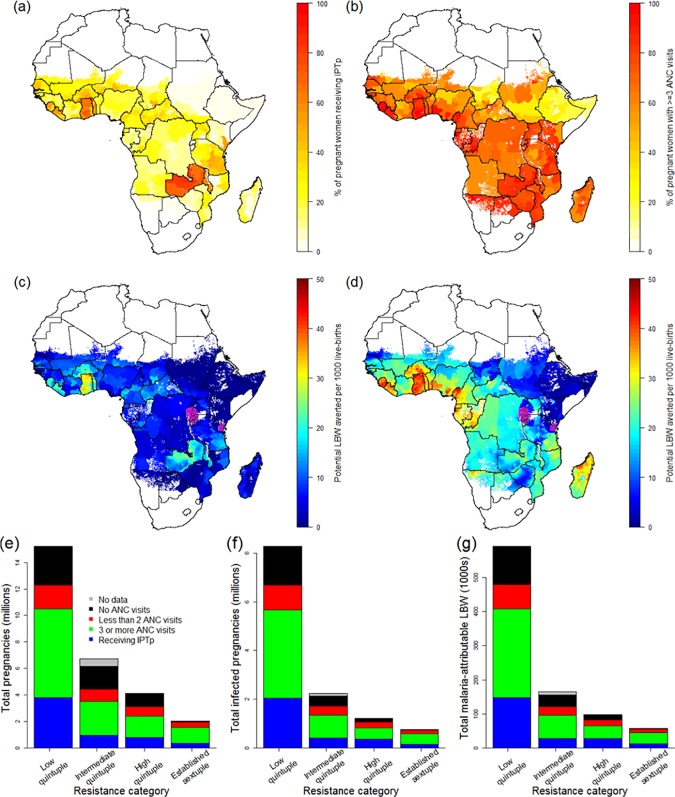
The current coverage of IPTp-SP and potential impact of scale-up.(A) Current coverage of IPTp (at least two doses of SP received at some stage during pregnancy) by first administrative unit according to the most recent population-based survey. (B) Current coverage of women visiting an ANC clinic at least three times during pregnancy. (C) Estimate of the current impact of IPTp-SP given current coverage, SP resistance, and transmission intensity (purple areas show settings where the sextuple mutation has become established, where we do not make an estimate of efficacy). (D) Estimate of the impact of IPTp-SP if given to all women visiting an ANC clinic at least three times, with purple areas as in (C). (E) Estimates of the total number of pregnancies receiving IPTp, and the ANC status of those who do not, by resistance category. (F) Equivalent estimates of total infected pregnancies. (G) Equivalent estimates of potential malaria-attributable LBW deliveries. ANC, antenatal care; IPTp, intermittent preventive treatment of malaria in pregnancy; IPTp-SP, intermittent preventive treatment of malaria in pregnancy with sulphadoxine-pyrimethamine; LBW, low birthweight; SP, sulphadoxine-pyrimethamine.